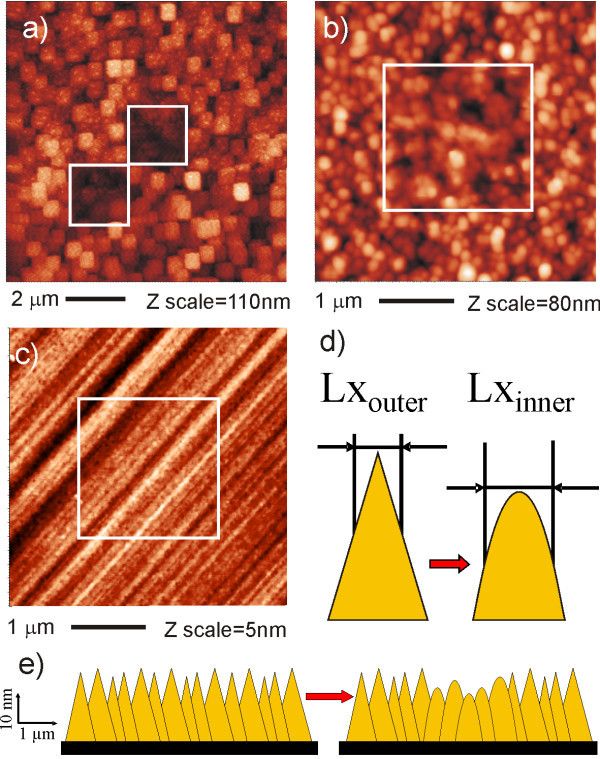
Wear of diamond substrates in contact mode AFM. (a) Two 2 × 2 μm2 CM scans with F = 3 μN were made in the central area using NSG01 tip with k = 3 N/m. Overall image in TM reveal holes with depth h = 20 ± 15 nm. (b) CM nanoshaving (2 × 2 μm2) image of NCD was made in air using NSG01 tip with applied force F = 1.5 μN. Overall image in TM reveal hole with depth h = 6 ± 12 nm. (c) CM nanoshaving (1 × 1 μm2) on MCD surface was made using NSG01 tip with F = 3 μN (k = 3 N/m). Overall image in TM (2 × 2 μm2) reveals absence of any changes on the surface. (d) The model illustrating wear of NCD grains by Si cantilever. CM nanoshaving makes NCD grains more rounded and their Lx values slightly increases. (e) The model illustrates formation of a depression in the NCD surface by the wear of NCD grains during AFM scanning in CM.